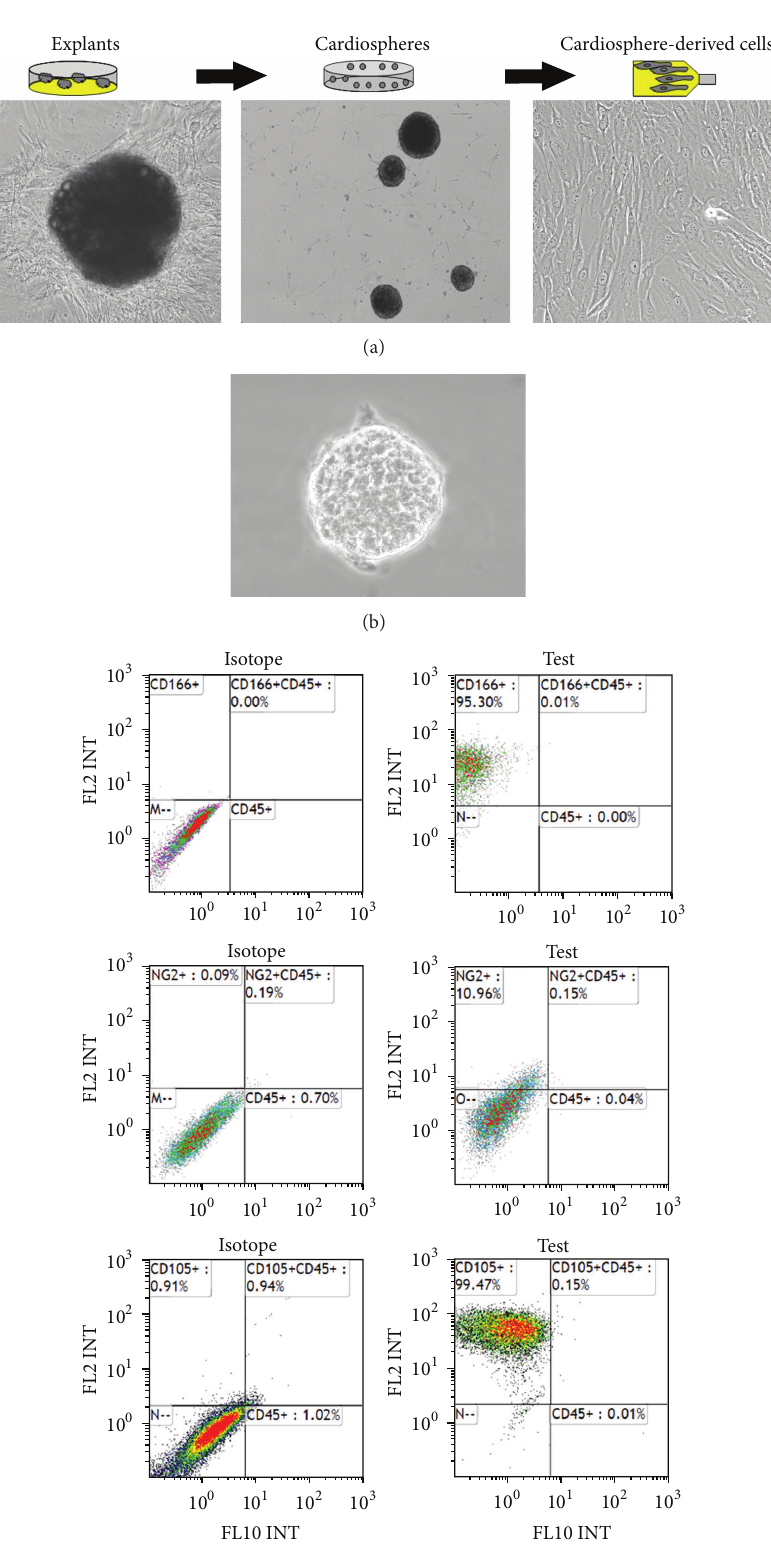
Figure 1: (a) Photomicrographs of a human atrial appendage specimen in the primary culture giving rise to a cellular outgrowth (left panel); CSs (middle panel); CDCs (right panel). (b) High magnification view of a human CS. (c) Flow-cytometric analysis of cell-surface marker expression by CS-forming cells (top to bottom: plots for CD45 versus CD166, CD45 versus NG2, and CD45 versus CD105